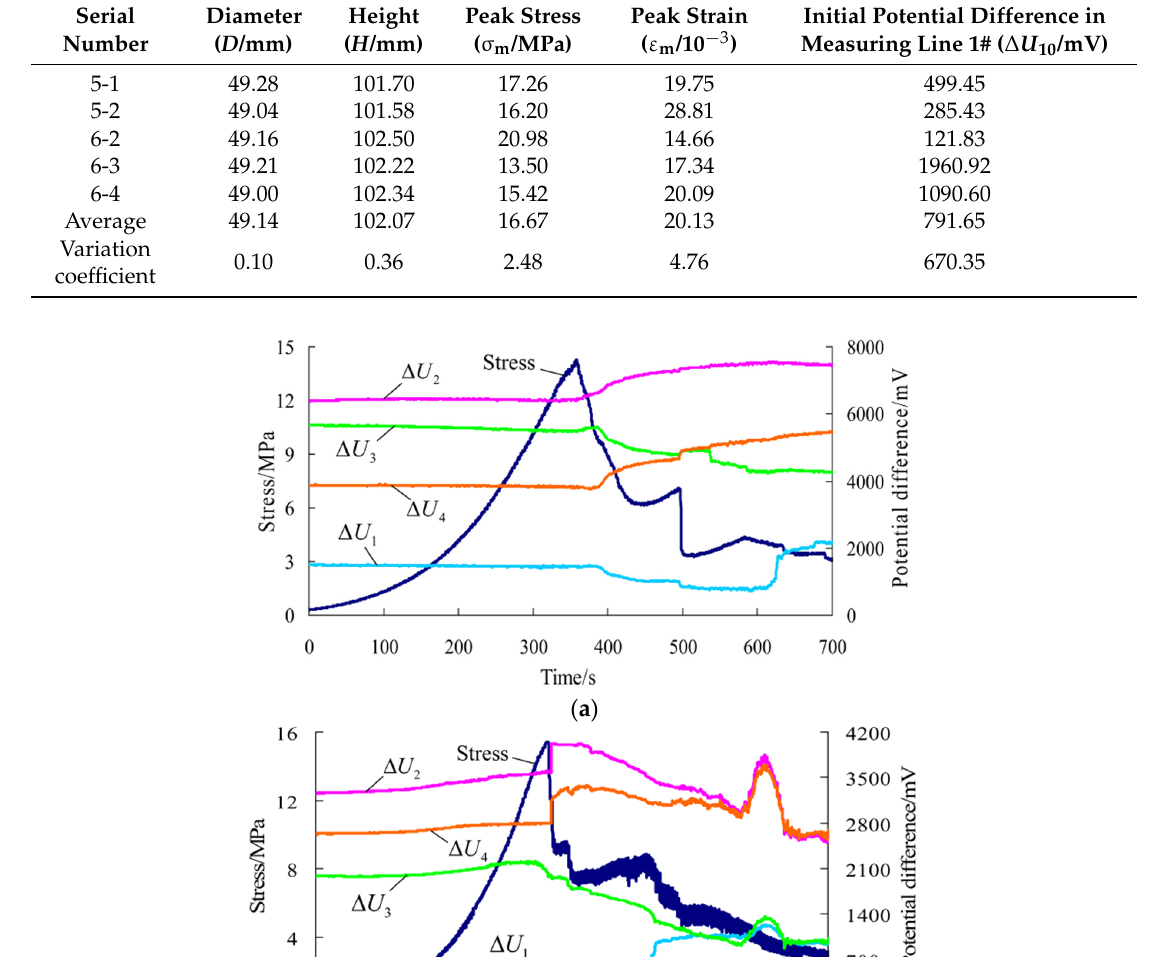
Table 2. Test results of rock samples normal to the bedding direction in uniaxial compression test.